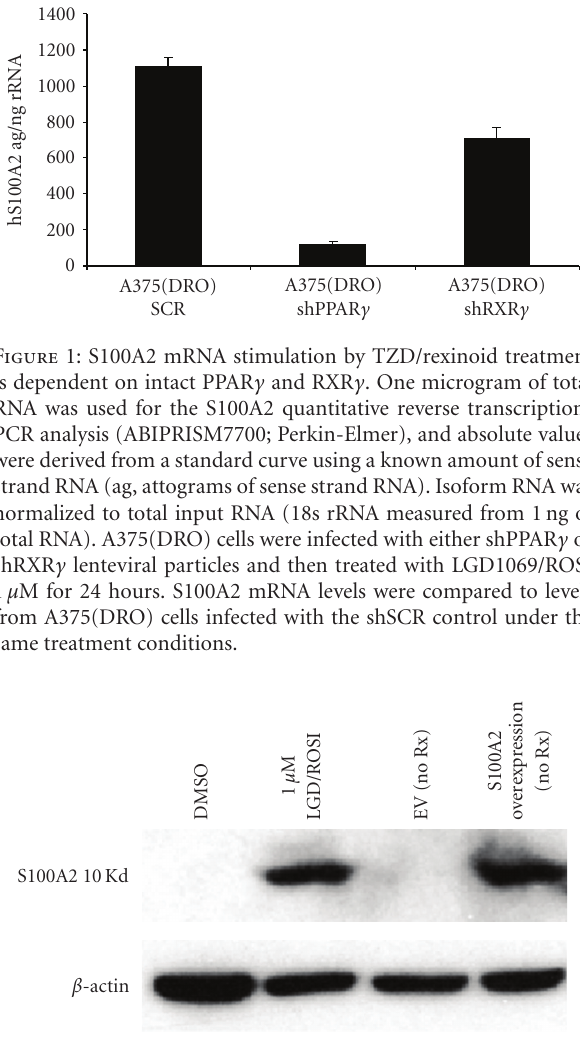
Figure 2: Protein expression of S100A2 in A375(DRO) cells. 60 μ g of nuclear protein extract from A375(DRO) before (DMSO—lane 1) and after combination treatment (lane 2) or transfected with empty vector (EV—lane 3) or S100A2 in pcDNA3 vector with no treatment (lane 4) was size-separated on a 10% SDS-PAGE gel and transferred to nitrocellulose. The blot was blocked with 10% nonfat milk and incubated with S100A2 receptor antibodies (sc Y-20). β - Actin was measured as a loading control.